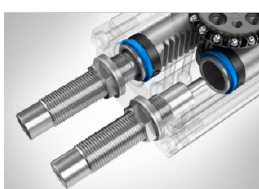
pneumatic motors, such as semi-rotary motors, as shown in Figure 2.